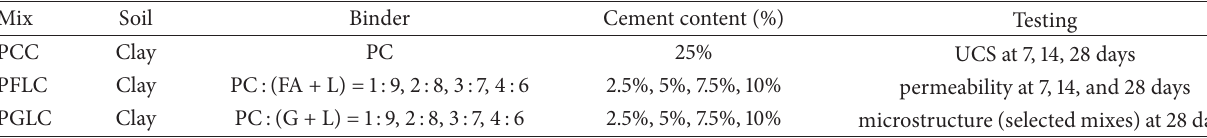
Table 3: Testing program.